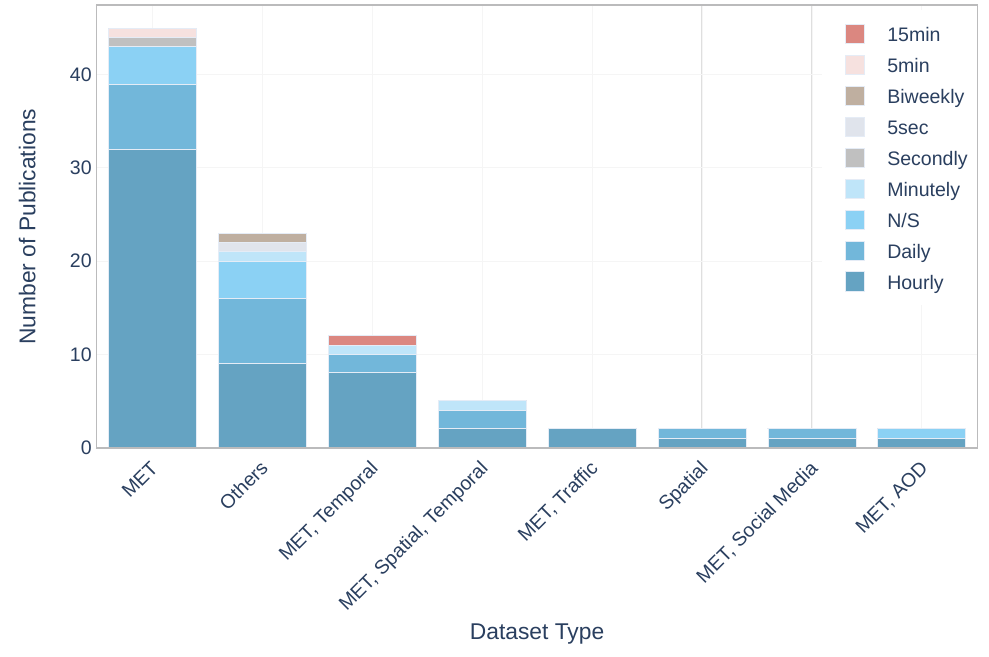
Figure 6. The number of publications of dataset combinations in terms of data rate. Period (Days) : is the period (the number of days) of the data collection. The summary statistics of these days reveals a mean of days of 1300.63 days ( Std.Dev : 1484.68) and a median of 731 days ( Min : 3 and Max :